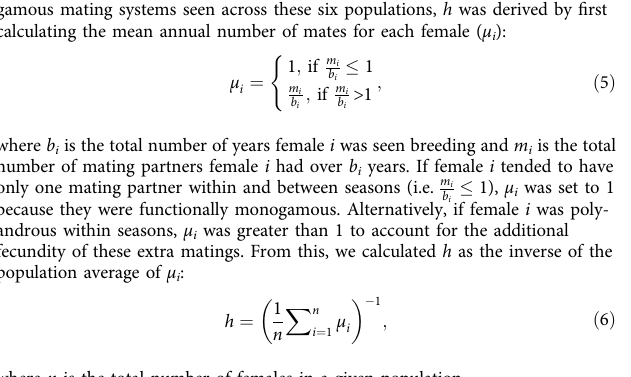
Life table response experiment of ASR contributions . Perturbation analyses provide information about the relative effect that each component of a matrix model has on the population-level response, in our case ASR. To assess how in fl uential sex biases in parameters associated with each of the three life stages were on ASR dynamics, we employed a life table response experiment (LTRE). An LTRE decomposes the difference in response between two or more “ treatments ” by weighting the difference in parameter values by the parameter ’ s contribution to the response (i.e. its sensitivity), and summing over all parameters 20 . Our LTRE compared the observed scenario ( M ), to a null scenario with no sex differences ( M 0 ), whereby all male survival rates were set equal to the female rates ( M 0 ♀ ), the hatching sex ratio was unbiased (i.e. ρ = 0.5), and mating system was monogamous (i.e. h = 1). Thus, our LTRE identi fi es the drivers of ASR bias by decomposing the absolute parameter contributions to the difference between the ASR predicted by our model and an unbiased ASR 18 . To verify if our method was robust, we also evaluated a null scenario in which all female survival rates were set equal to the male rates ( M 0 ♂